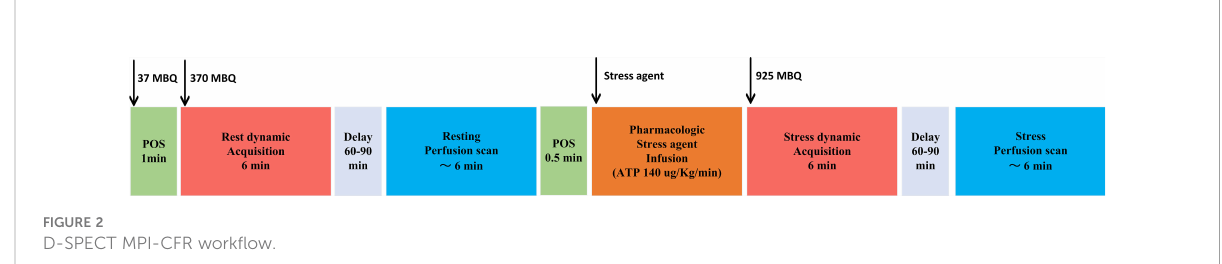
FIGURE 2 D-SPECT MPI-CFR work fl ow.